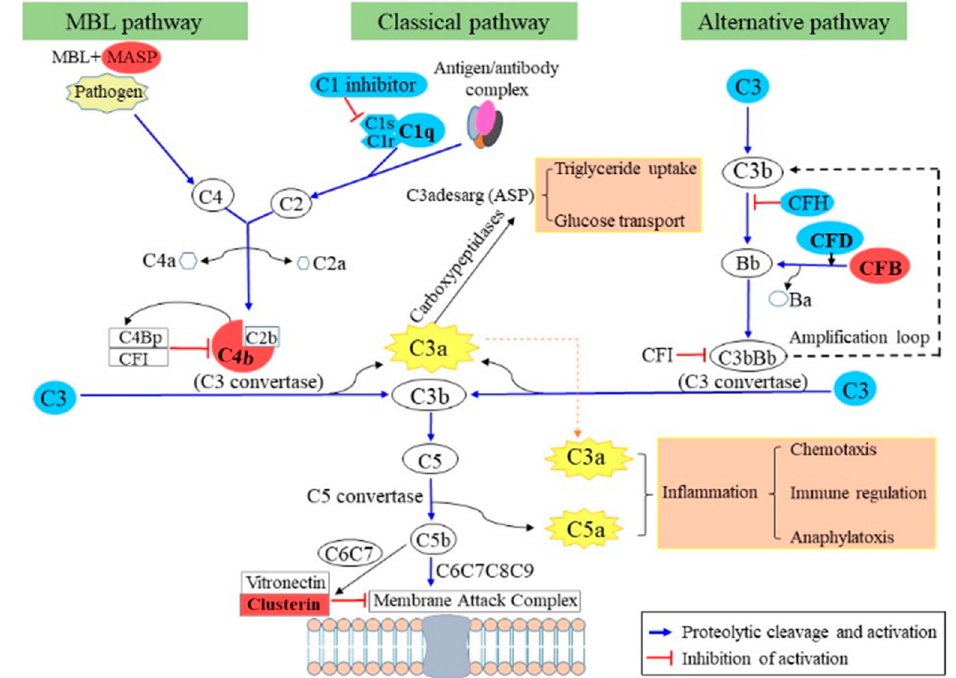
Figure 2. Complement activation pathway comparing GR plus RF with NF. Secreteome changes during GR plus RF vs NF indicate the up regulation of MBL and alternative pathways of the complement system, which may trigger the uptake of triglycerides and glucose by adipocytes on one hand and promote inflammation on the other, which both may have an effect on health after weight regain. Proteins in blue means that the expression was down-regulated ( p < 0.1), red means up-regulated ( p < 0.1), white are proteins that were not detected in our results. RF: refeeding, NF: normal feeding, GR: glucose restriction. MBL: mannose-binding lectin. MASP: mannose-binding lectin serine protease.